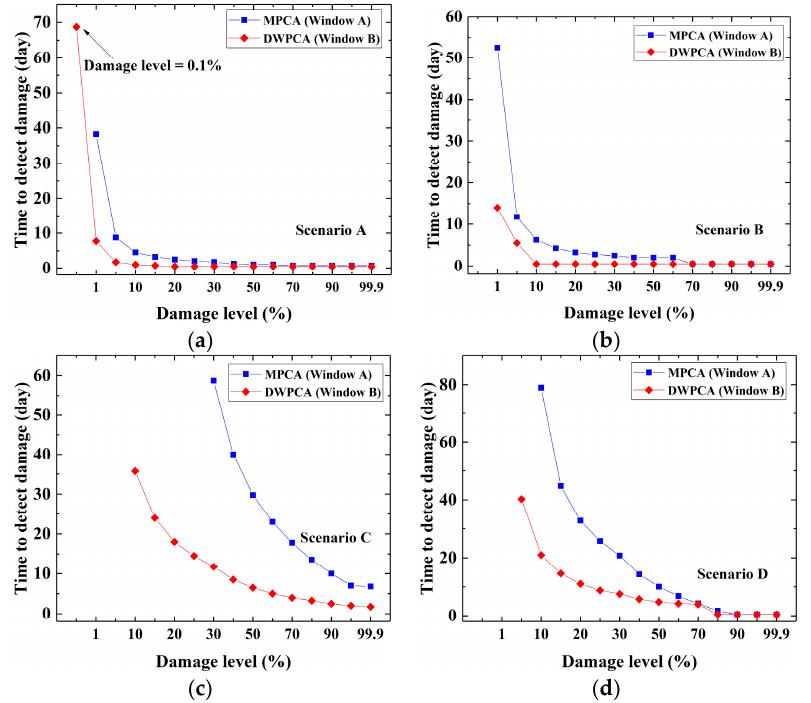
Figure 7. Time to detect damage after damage occurrence with respect to the damage level: ( a ) Scenario A; ( b ) Scenario B; ( c ) Scenario C; ( d ) Scenario D. Table 1. Detection resolution of moving principal component analysis (MPCA) and double-window PCA (DWPCA) for different scenarios.